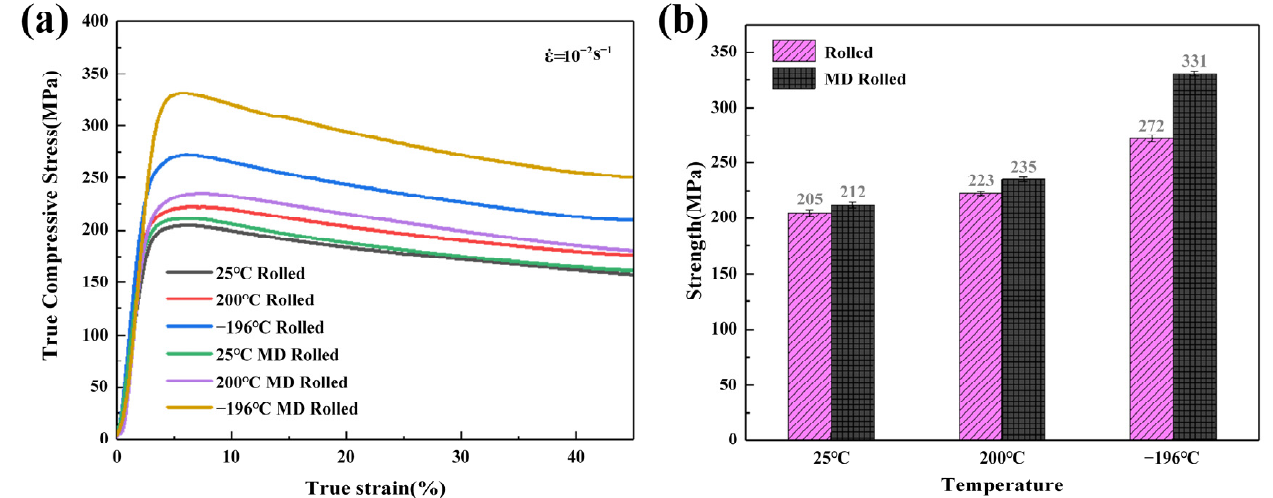
Figure 2. ( a ) Valid segment of compressive true strain-true stress curve; ( b ) histogram of compres- sive strength.